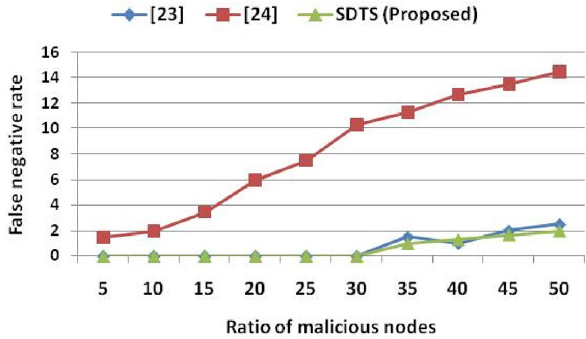
Figure 6. Ratio of malicious nodes vs. false negative rate.